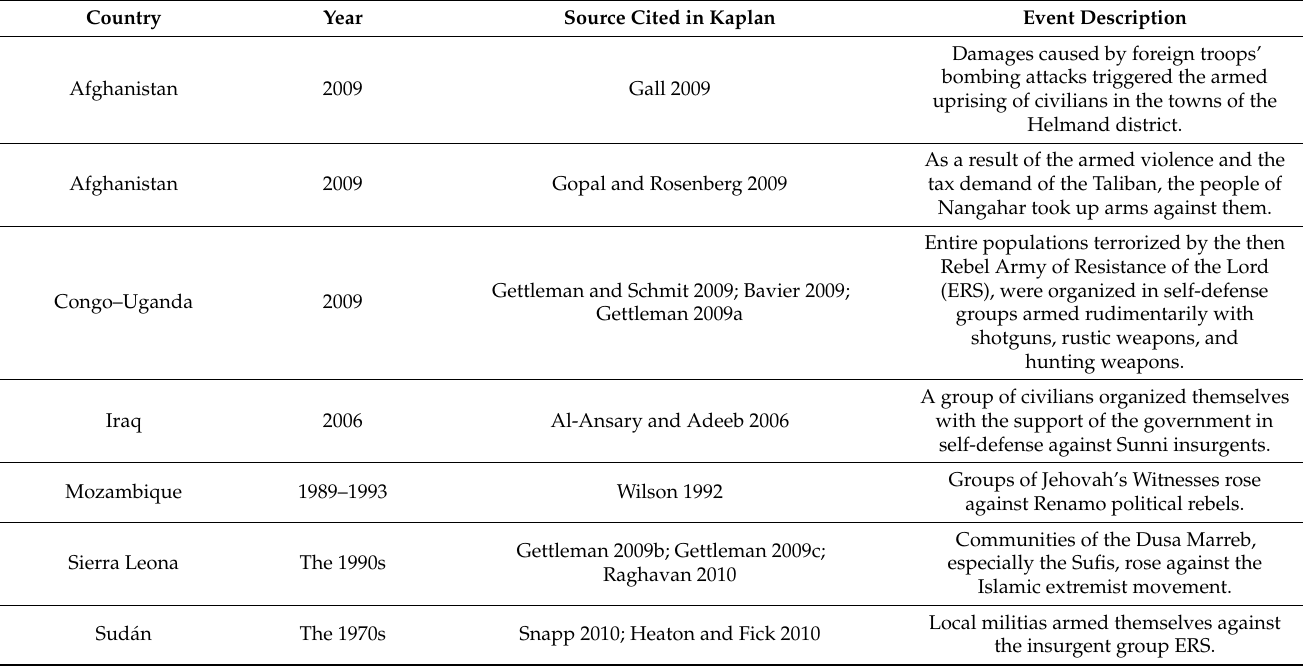
Table 1. Compendium of experiences of armed responses of